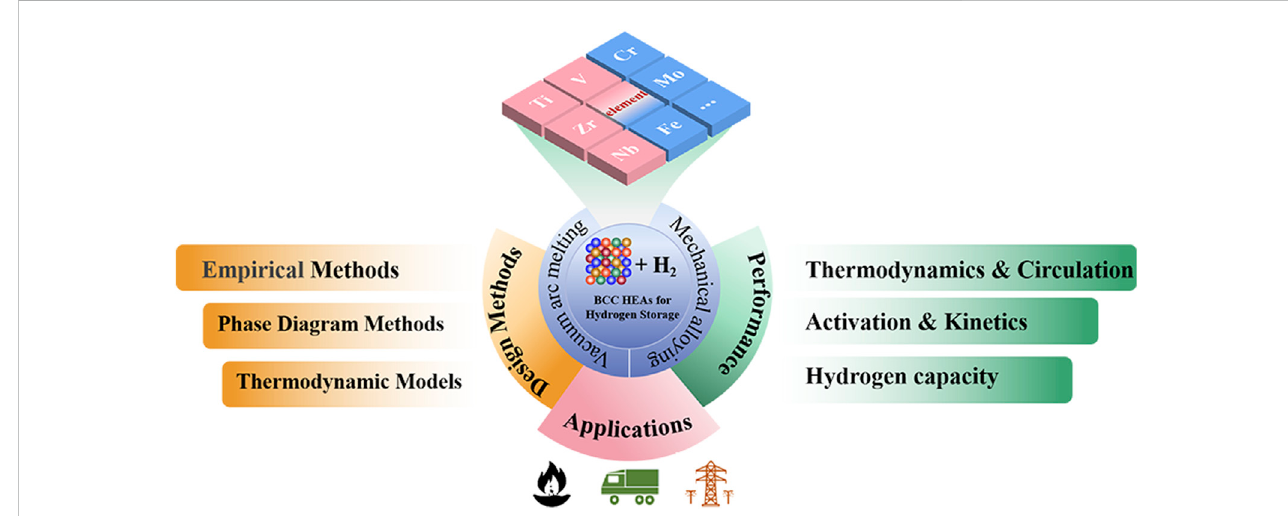
FIGURE 1 Diagram showing the design, synthesis, hydrogen storage properties and applications of BCC-structured